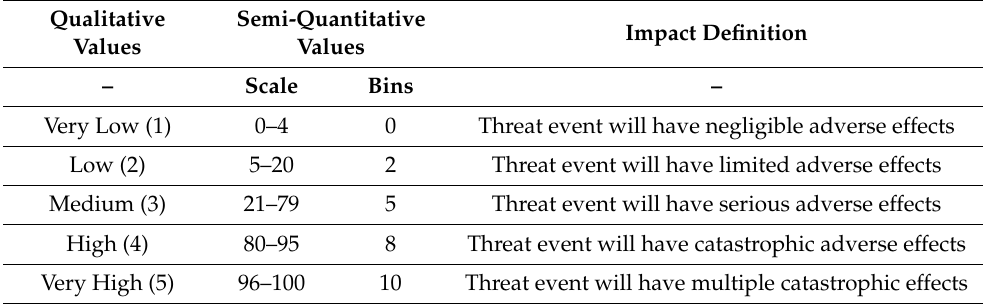
Table 5. Assessment scale for impact.